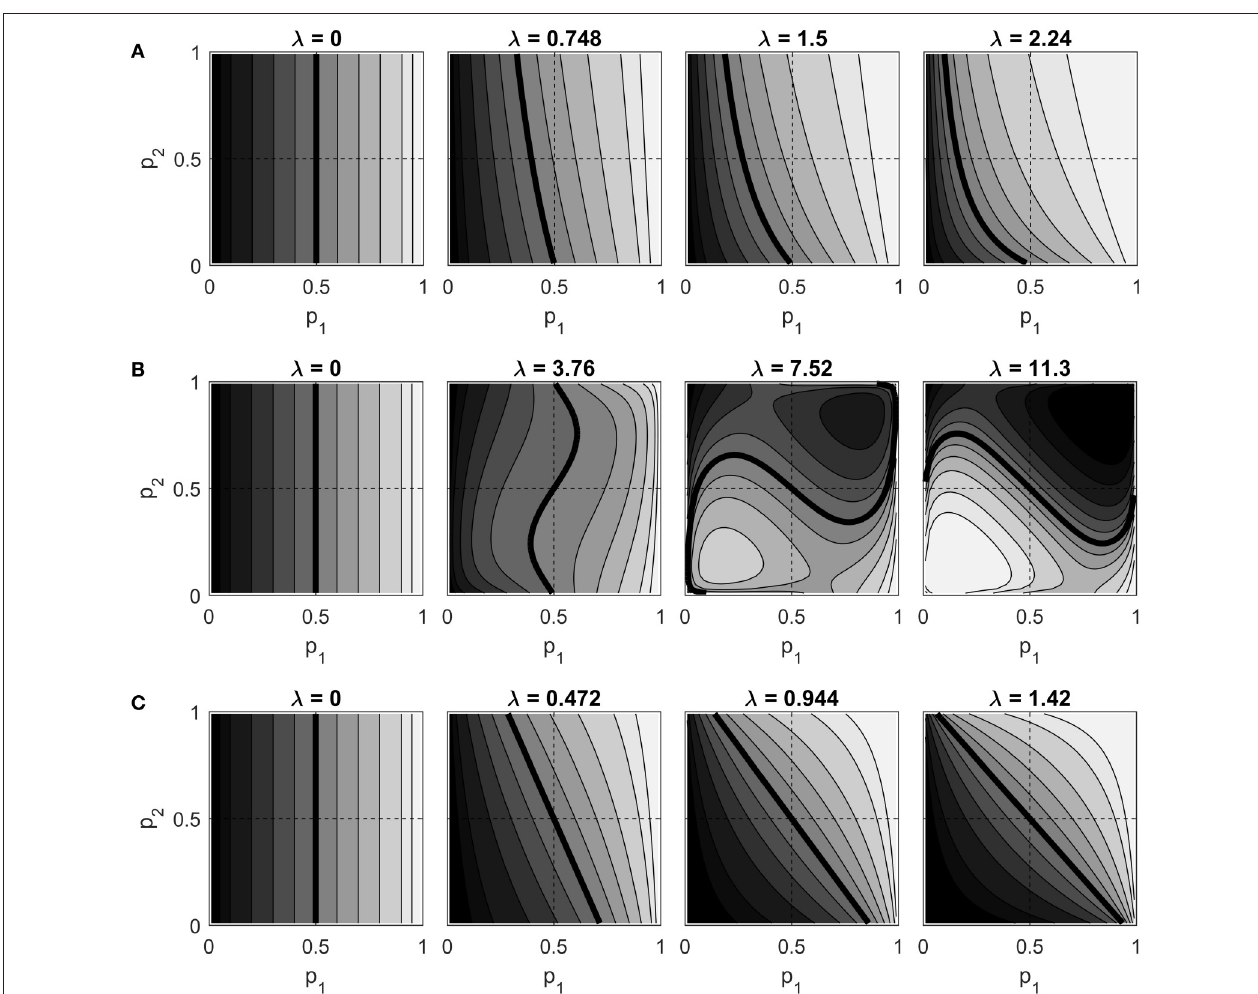
h ) vs. p 1 and p 2 for different λ values, for (A) the S 0,1 model, (B) the C 0,1 model, and (C) the S FIGURE 4 | Contour plots of Pr ( Z 1 = drawn at probabilities 0.05,0.1,0.2, ... ,0.9,0.95, with lighter shades of gray representing higher probabilities. The probability 0.5 contour is thicker than the rest. Dashed lines are drawn horizontally and vertically through the point (0.5,0.5), which corresponds to α 1